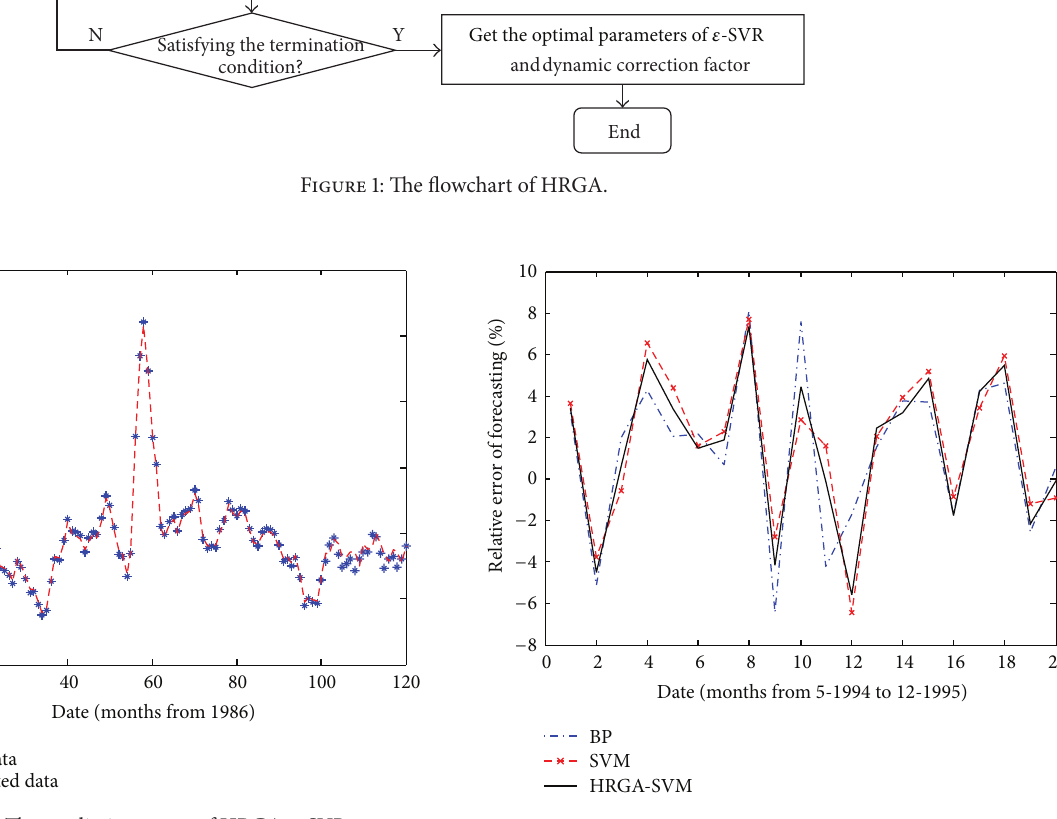
Figure 3: Errors analysis with different